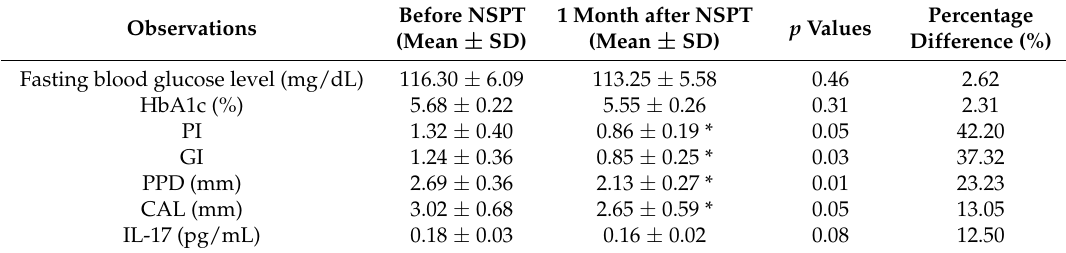
Table 1. Comparison of periodontal and biochemical parameters within the group-I before NSPT and 1 month after NSPT. p Value < 0.05 was considered as statistically